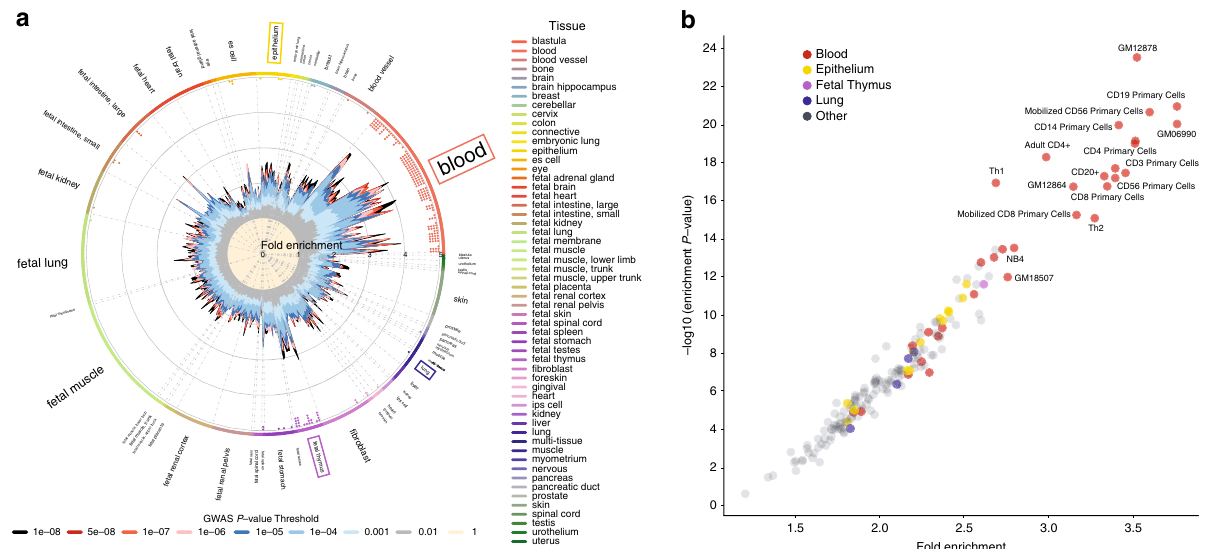
Fig. 4 Enrichment analyses with asthma-associated variants. a GARFIELD analysis revealed highly signi fi cant 3 to 4-fold enrichment of asthma- associated variants colocalizing to DNase I hypersensitive sites (peaks) in several asthma-related tissues, such as blood (red box), epithelium (orange box), lung (blue box), and thymus (purple box). The radial plot shows fold enrichment in various available tissues using different GWAS signi fi cance thresholds for the inclusion of asthma-associated variants in the GARFIELD analysis, as calculated by logistic regression. The small dots on the inside of the outer most circle indicate whether the inclusion of asthma-associated variants at GWAS signi fi cance thresholds of 1.0 × 10 − 5 (one dot), 1.0 × 10 − 6 (two dots), 1.0 × 10 − 7 (three dots), 1.0 × 10 − 8 (four dots) in the GARFIELD analysis yielded signi fi cant enrichment in that tissue or cell type at P = 1.0 × 10 − 15 . b Highly signi fi cant enrichment in DNase I hypersensitive sites was particularly evident in immune cells, such as GM12878 B cells, CD19 + B cells as well as CD3 + , CD4 + , and CD8 + T